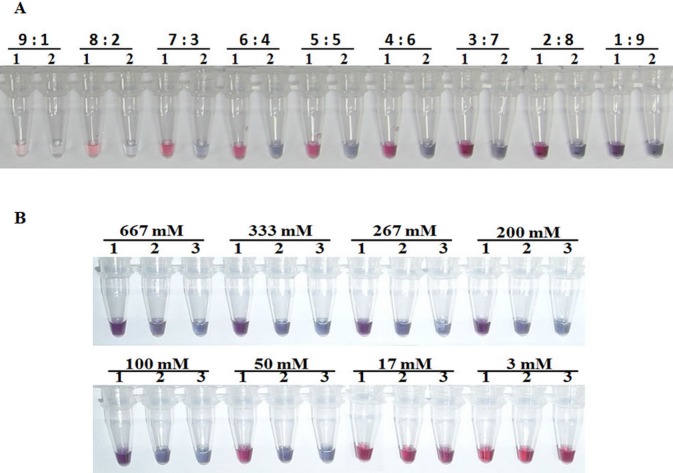
Optimization of AuNP hybridization for detection of VPAHPND amplicons.(A) Effect of variation in the volume ratio of the AuNP probe solution (5 nM) and the VPAHPND LAMP amplicon solution from 1:9 to 9:1 (gold probe:Lamp amplicon) followed by addition of 50 mM MgSO4 and showing that 5:5 was the best ratio. (B) Effect of variation in MgSO4 concentration (between 3 and 667 mM in a fixed volume) in tubes with a gold probe: Lamp amplicon ratio of 5:5 and containing either (1) VPAHPND LAMP amplicon or (2) WSSV LAMP amplicon (non-complementary DNA target negative control) or (3) LAMP premix without DNA target (no-target negative control) and showing that 50 mM gave the best result.